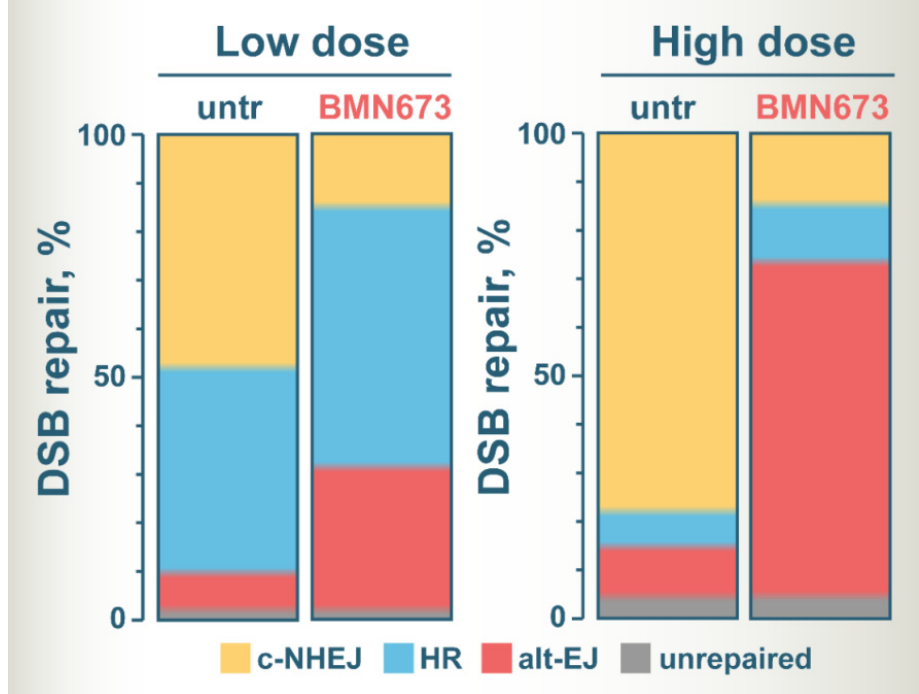
Figure 3. A model of altered DSB repair pathway balance at low and high IR doses in BMN673-treated cells. See text for details.